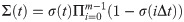
SVEIR model of rubella infection.(A) The transition diagram. The internal states of individuals are categorized into susceptible (S), vaccinated (V), exposed (E), infectious (I), or recovered (R) classes. The transmission rate from S to E is denoted by βS and that from V to E by βV. The transition from S to V was assumed to occur according to the data on vaccination in Kawasaki City or with a transition probability parameter, depending on the simulation. (B) The expected value of the transition probability that an exposed individual changes to an infectious one at time t = mΔt(m = 0, 1, 2, …). It is represented as Σ(t)=σ(t)Πi=0m-1(1-σ(iΔt)) where the incubation rate σ in each time is is given by Eq (1). The parameter values were set at aEI = 1.025, bEI = ln(aEI)/4, and Δt = 0.1 days. (C) The expected value of the transition probability that an infectious individual changes to a recovered one at time t = mΔt(m = 0, 1, 2, …). It is represented as Γ(t)=γ(t)Πi=0m-1(1-γ(iΔt)) where the recovery rate γ is given by Eq (2). The parameter values were set at aIR = 6.5, bIR = ln(aIR)/12, and Δt = 0.1 days. See S1 Appendix for details about the settings of the parameters, aEI, bEI, aIR, and bIR.